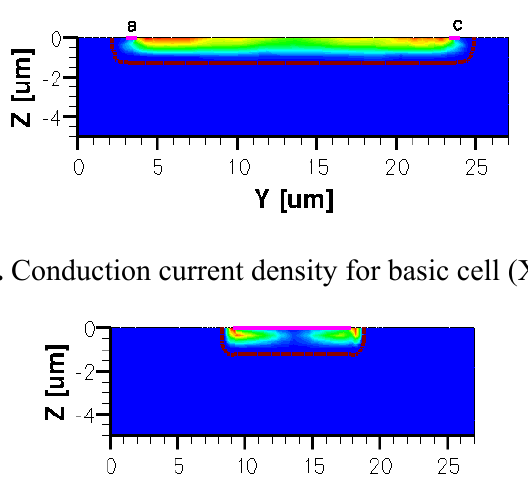
Figure 16. Conduction current density for basic cell with emphasis on the biasing contacts a and c.